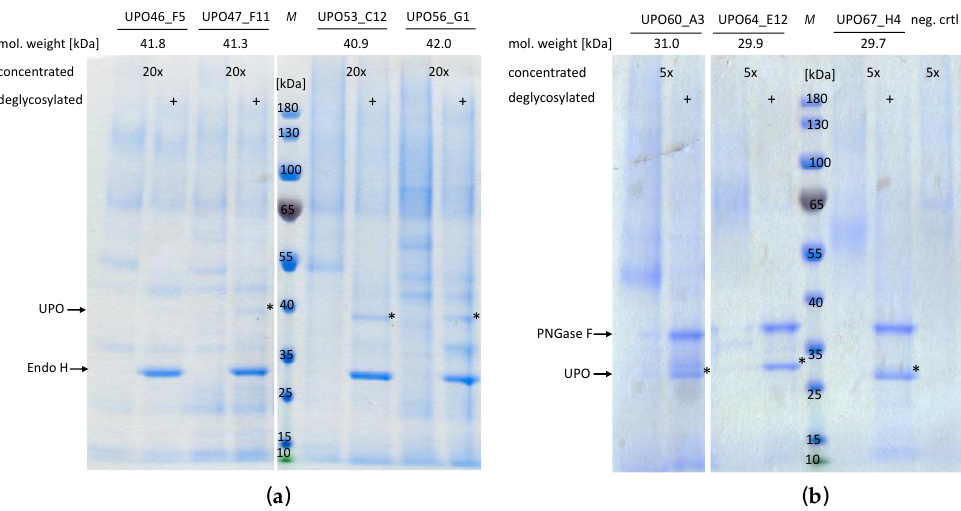
( a ) ( b ) Figure 4. SDS PAGE analysis of shake flask cultivation supernatant of K. pfaffii strains expressing novel ( a ) family II (long) and ( b ) family I (short) UPOs. Culture supernatant was concentrated 5 or 20-fold, for family I and family II UPOs, respectively. Sample and gel preparation was done under standard conditions for reduced and denatured SDS PAGE. Each enzyme was applied in a native (left) and deglycosylated form (right, marked by +). Family II and family I UPOs were treated with 500 units EndoH (expected size 29 kDa) or 500 units PNGaseF (expected size 36 kDa) for 16 h. Calculated molecular weights of novel UPOs based on the primary sequence were as follows: UPO 46: 41.8 kDa, UPO 47: 41.3 kDa, UPO 53: 40.9 kDa, UPO 56: 41.9 kDa, UPO 60: 31 kDa, UPO 64: 29.8 kDa, UPO 67: 29.7 kDa. Protein bands presumed to be target proteins are marked with an asterisk (*).